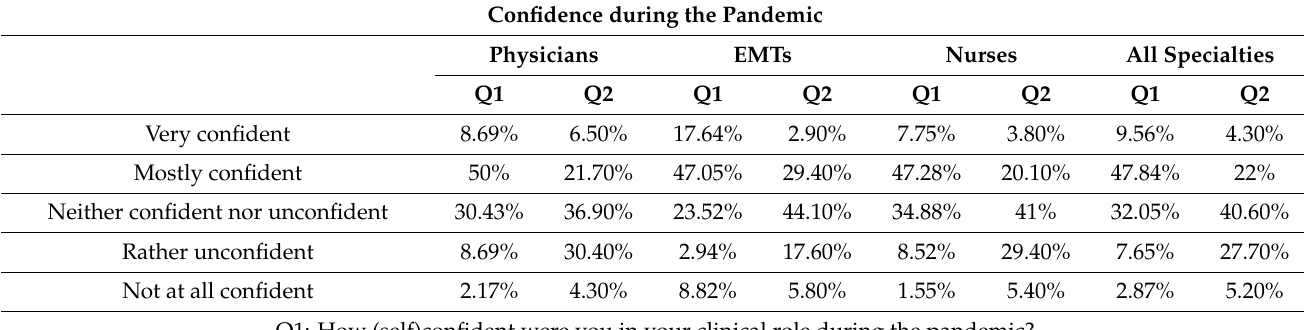
Table 2. (Self-)confidence in clinical role during pandemic (Question 1) and (self-)confidence in case of medical resource scarcity (Question